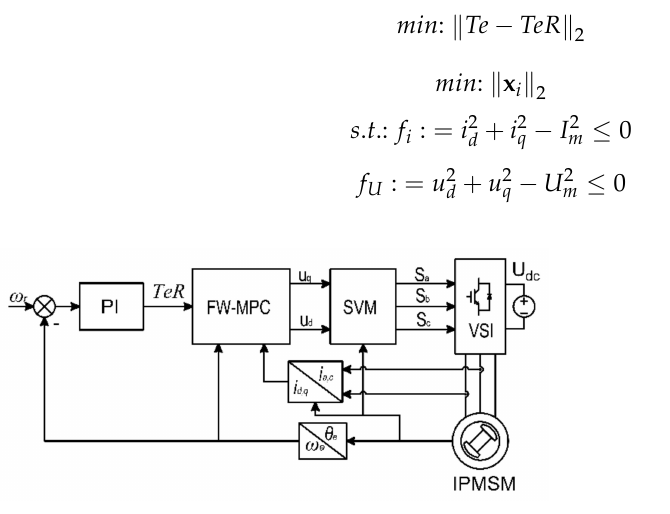
Figure 3. IPMSM drive system